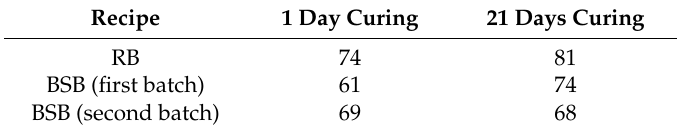
Table 7. Tumbling strength (TI values in %) of the reference briquettes (RB) and BF sludge briquettes (BSB). Recipe 1 Day Curing 21 Days Curing RB